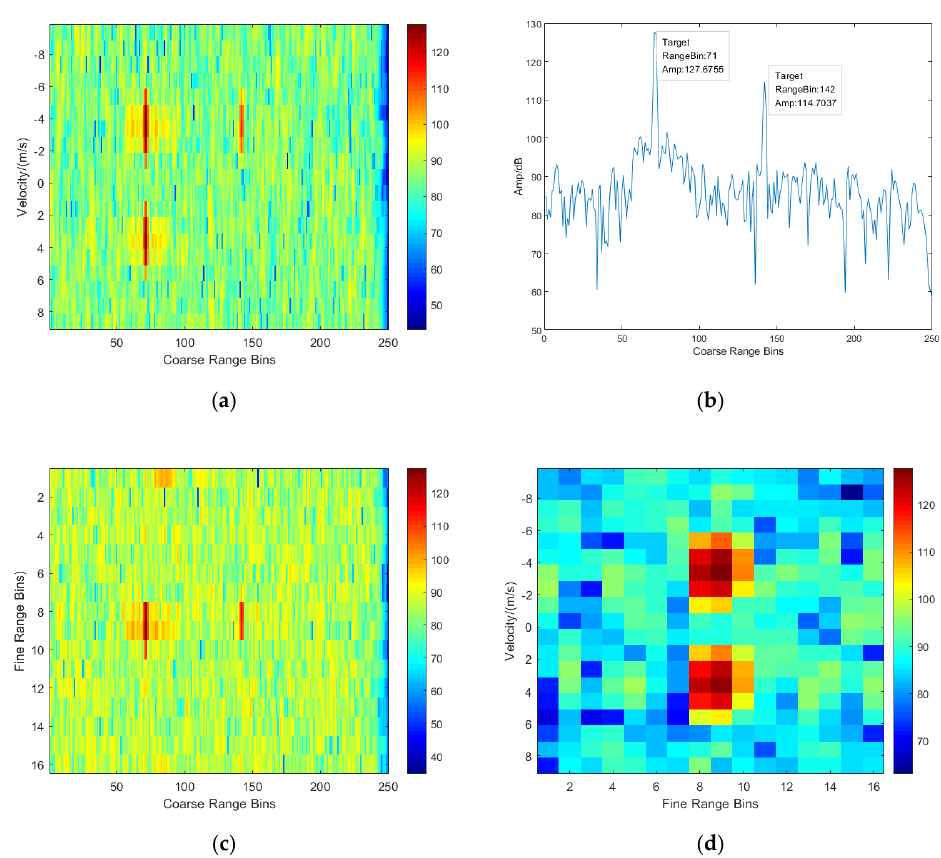
Figure 3. Echo plane after matched filtering for frequency-agile case. ( a ) Coarse range–velocity plane; ( b ) Range plot at the velocity of -3.5m/s; ( c ) Coarse range – fine range plane; ( d ) Fine range–velocity plane.